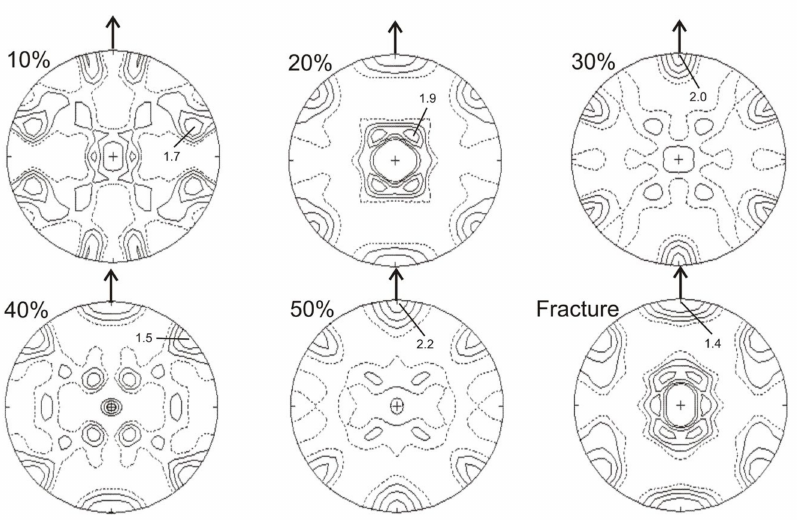
Figure 9. Calculated pole figures for α (cid:48) -martensite {110} after selected deformation